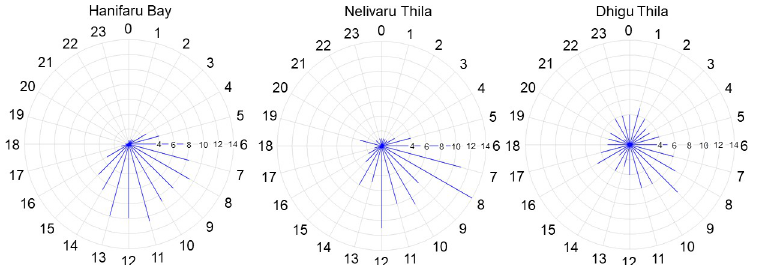
Fig 3. Distribution of resident events by hour of the day. Percentage distribution of resident events (start time) by hour of the day for Hanifaru Bay, Nelivaru Thila, and Dhigu Thila. Data for Fushifaru Kandu and Fares Kandu not shown as only nine resident events occurred between these